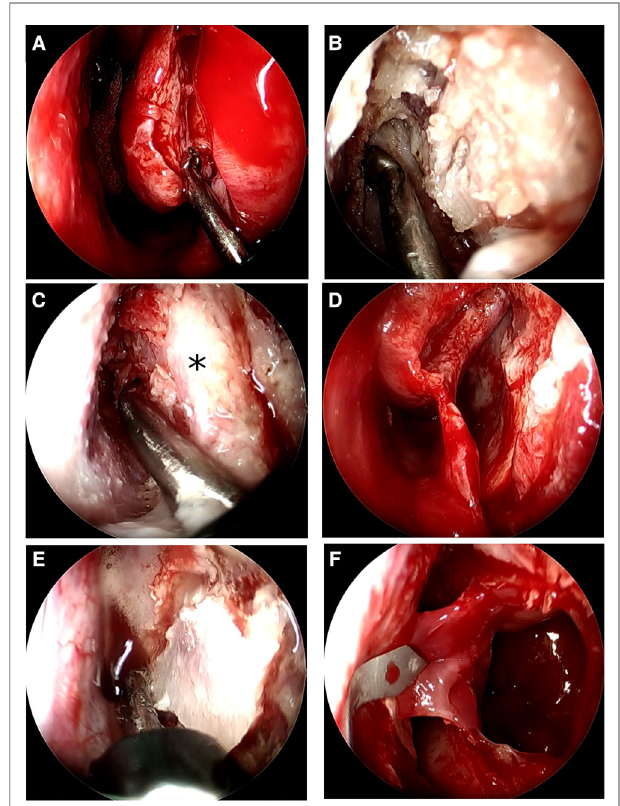
FIGURE 1 | The endoscopic intraoperative fi ndings of the left nasal cavity. ( A ) A mucosal incision was made from the anterior part of the lateral nasal wall to the bottom of the nasal cavity parallel to the mucocutaneous junction, behind the pyriform aperture, and the metal tip of the UBA was set on the attached portion of the IT bone. ( B ) Cutting of the IT bone attached to the lateral nasal wall proceeds upward to identify the NLD. ( C ) The UBA can crush the bone around the nasolacrimal duct without damaging the surrounding soft tissue. *=NLD. ( D ) The mucosa of the IT and the NLD was elevated and displaced medially from the lateral wall of the nasal cavity. ( E ) The bone on the outer wall of the nasal cavity is cut as needed with the UBA. Using brush-like strokes on the area to be cut without pressing hard, the UBA can cut without damaging the soft tissues at the back. ( F ) The MS mucosa can then be incised with a mucosal scalpel to gain access to the lesion within the